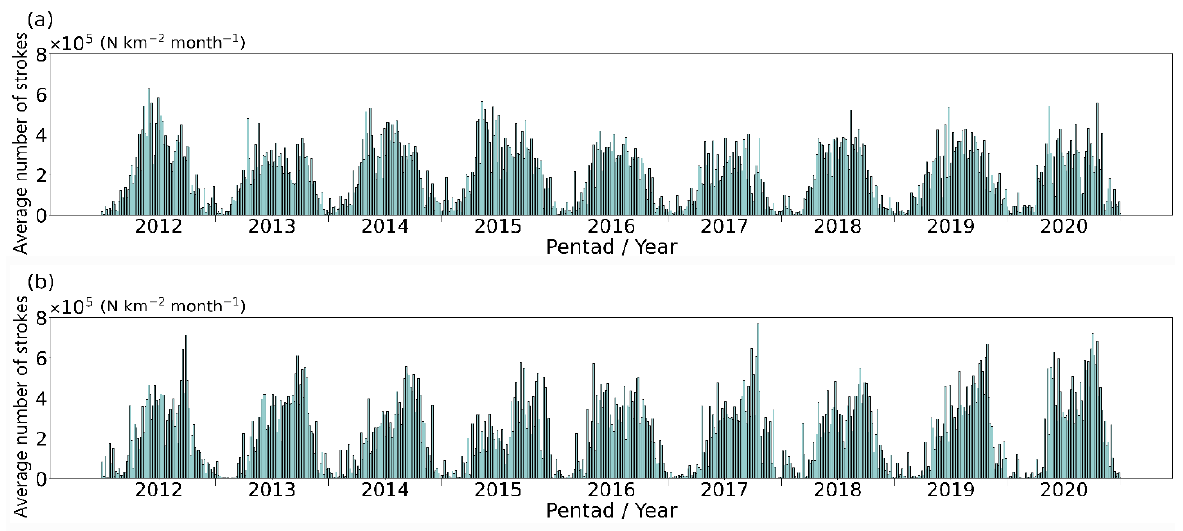
Figure 6. Average monthly distribution of lightning activity (total number of N km − 2 month − 1 ) over ( a ) the eastern tropical Pacific, and ( b ) the Caribbean Sea using the World Wide Lightning Location Network (WWLLN) data each year of 2006–2020.